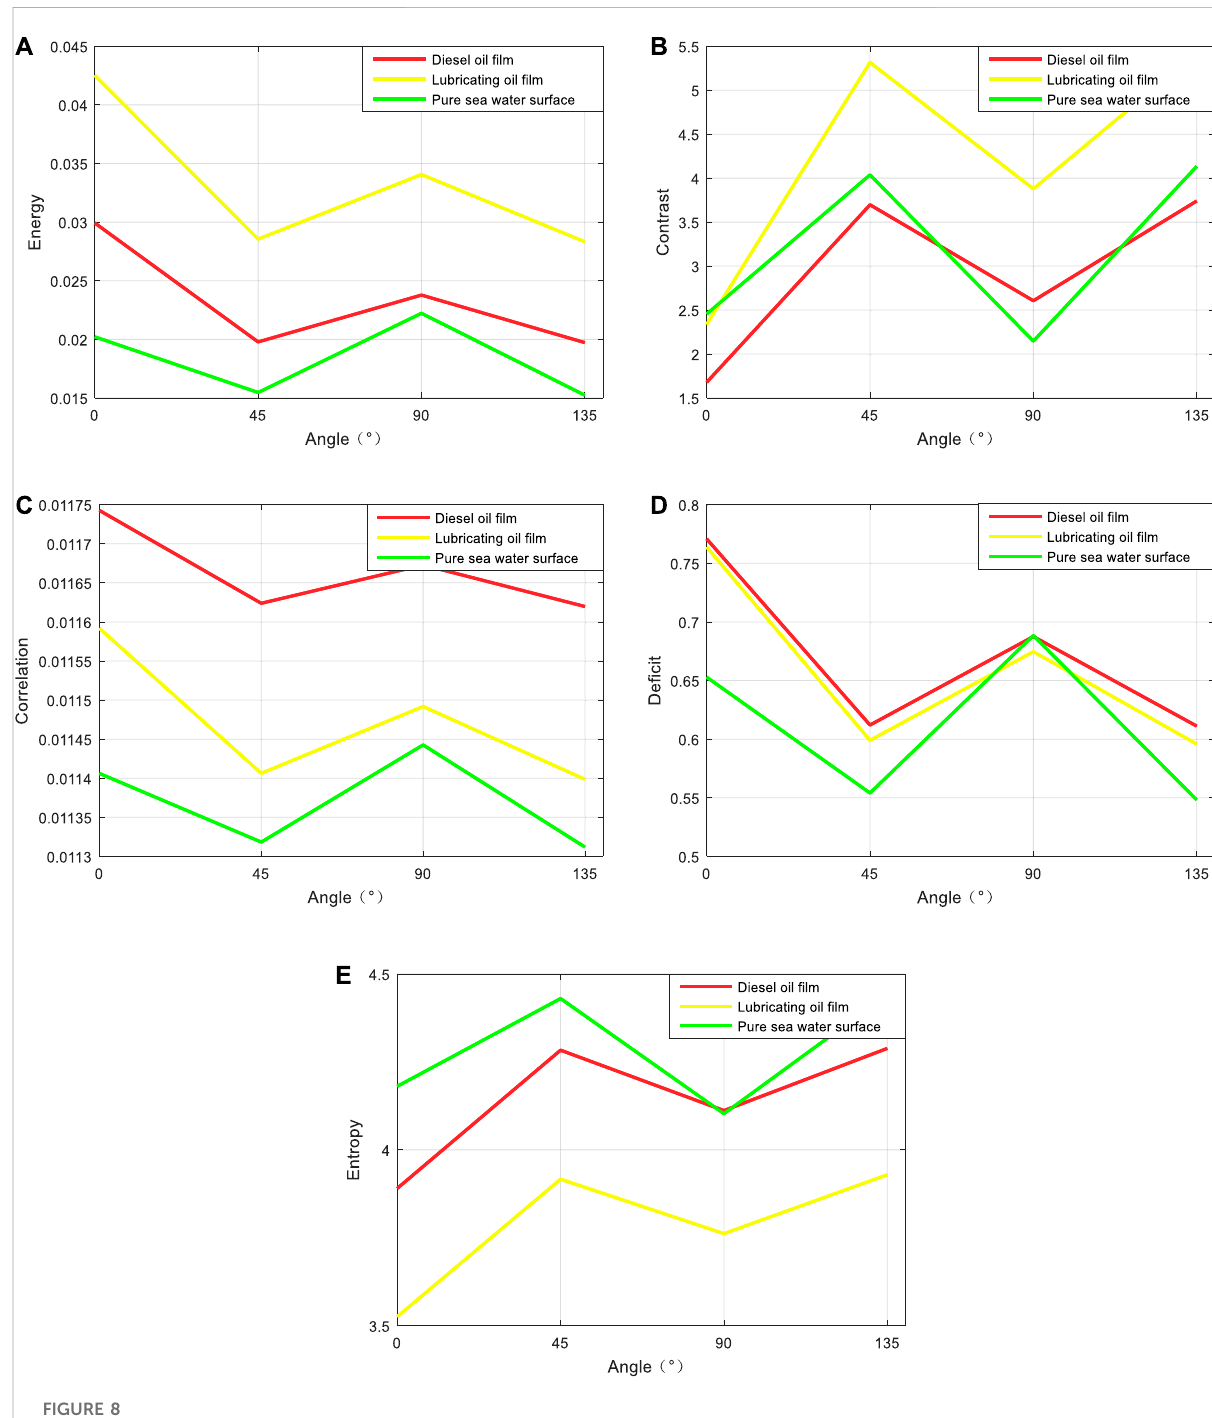
FIGURE 8 The GLCM eigenvalues of oil fi lm observation